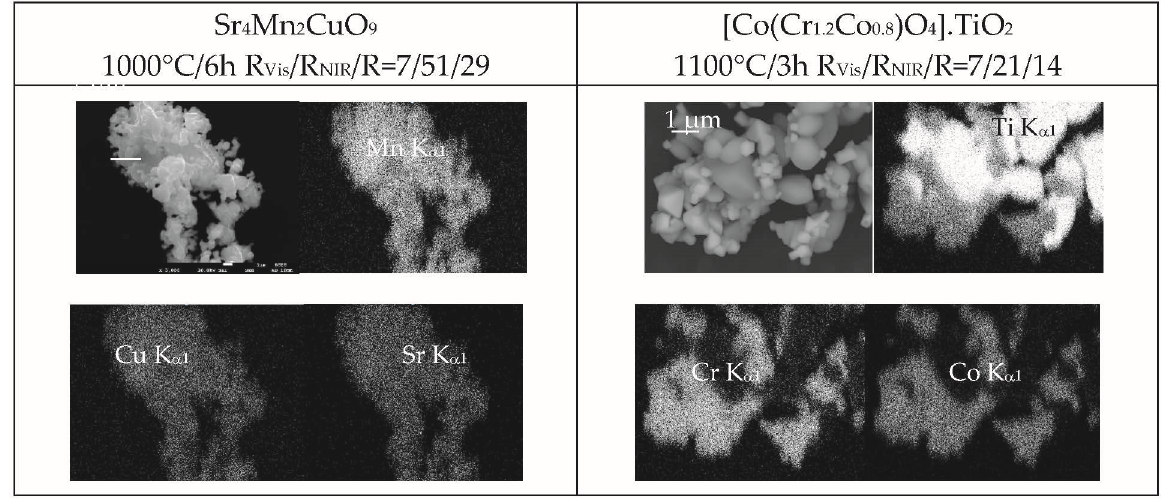
Figure 4. SEM and correlated EDX mapping of powders of the both families of pigments.